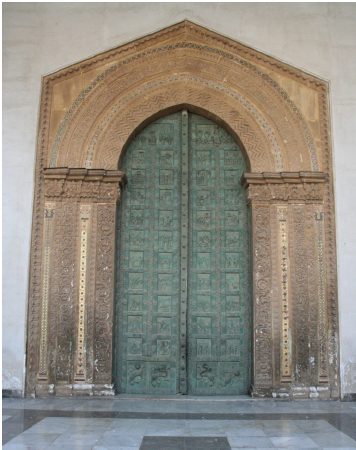
Figure 4. The main portal of the Cathedral of Monreale before the restoration